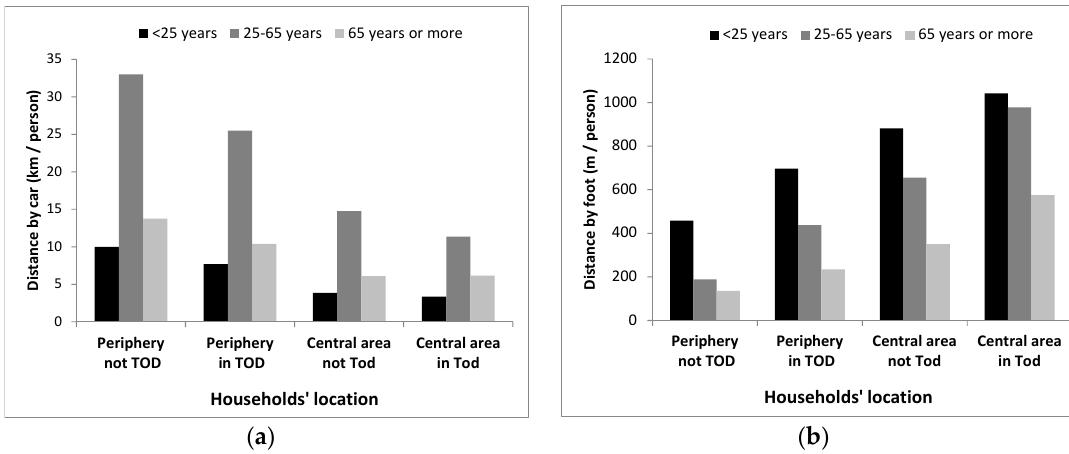
Figure 4. Average daily distance travelled (according to the method based on 2008 mode shares), by age group and households’ location (business as usual (BAU), 2031); ( a ) By car; ( b ) By foot (walk alone or for public transit (PT)).